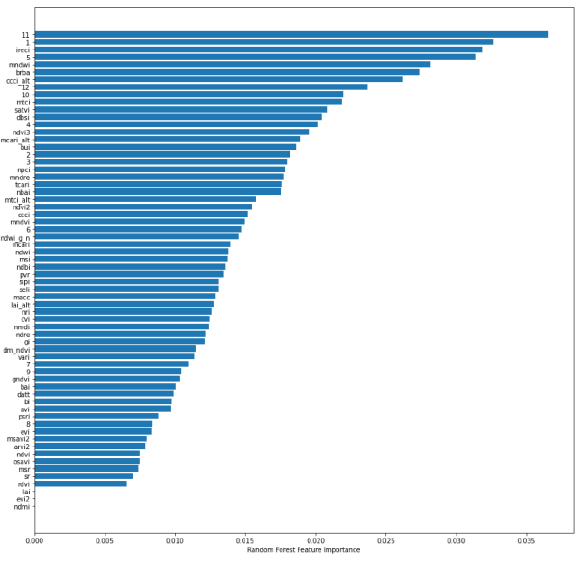
Figure 4 . Random Forest Feature